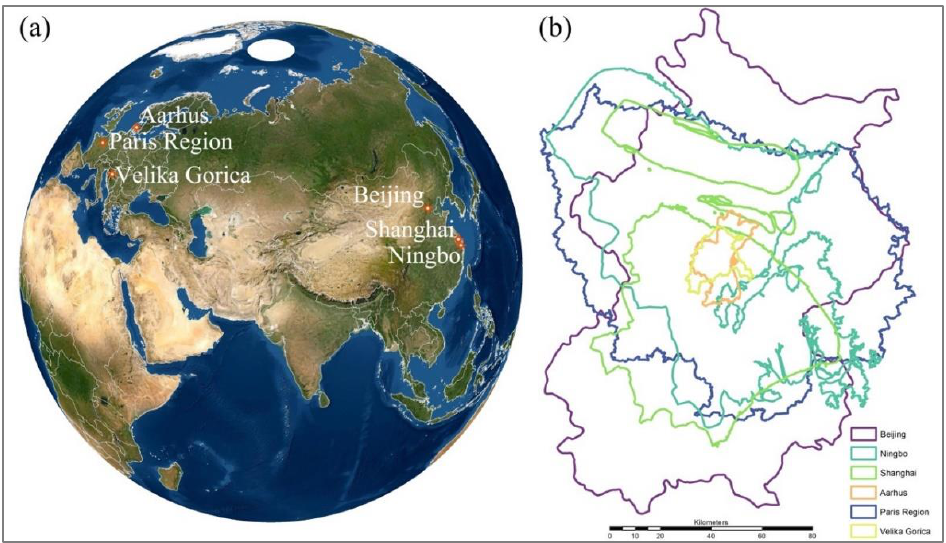
Figure 1. ( a ) Location of the six study cities and ( b ) comparison of their urban forms.